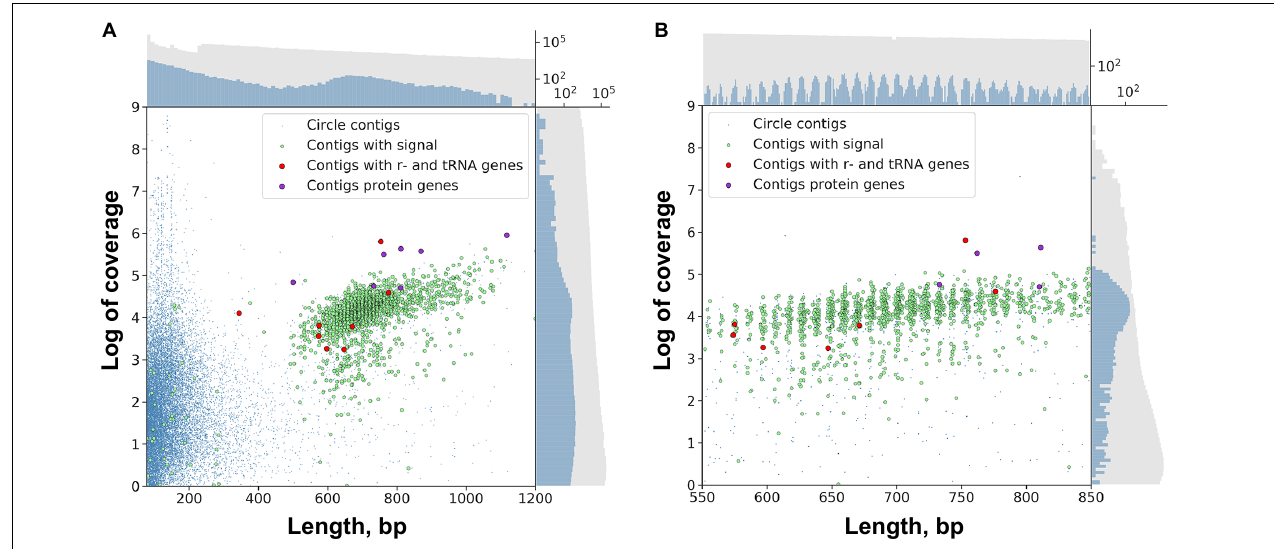
FIGURE 2 | Scatter plot of circular contigs in the Dicyema sp. genome. Different markers stand for circles with the specific signal and with mitochondrial genes (see Text for clarification). (A) The distributions for both length and coverage logarithm are non-uniform — there is a pool of “long” contigs with a high level of coverage in the set. (B) The distribution of “long” contigs with a high level of coverage is, in turn, non-uniform; the distance between two adjacent peaks is approximately 10.44 bp. On both scatterplots the upper axis shows the distribution of contig lengths, and the right axis shows the coverage. Blue dots correspond to circular contigs, and green dots are linear contigs. The scale is logarithmic. Both the coverage and length of circular contigs is obviously less uniform compared to those of linear contigs.